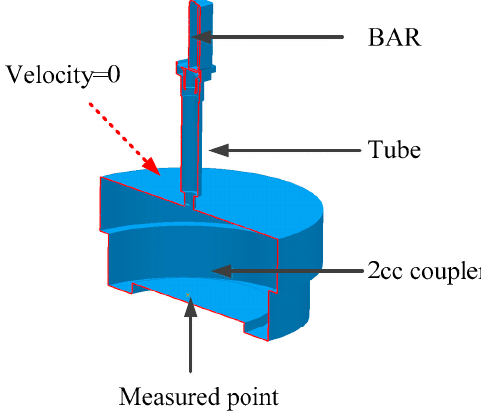
Figure 10. Modeling of acoustic BEM simulation. Table 2. Simulation detail by FEM and BEM.